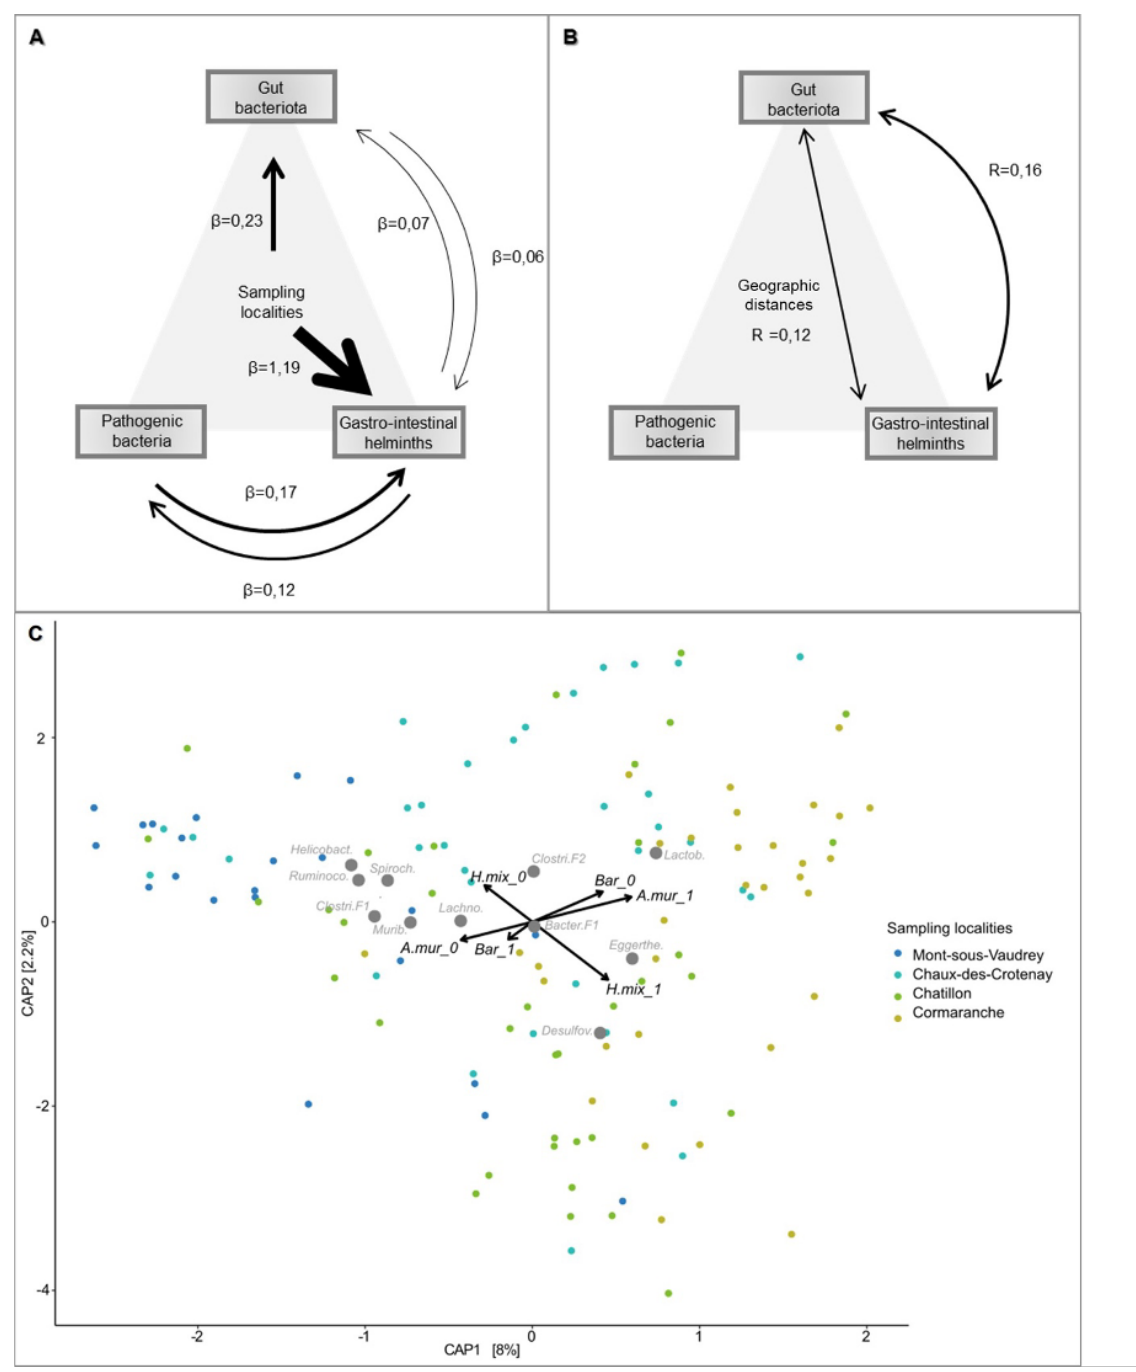
Figure 3- Associations between the diversity and composition of the three intra-host communities. The two upper diagrams show the relationships between A) the specific richness and B) the composition of the three communities, while taking into account the influence of the sampling localities or distance geographic. The effect size and the direction of the relationship between communities are represented using an arrow, its width corresponding to the estimate (β) x 10 or the correlation index R x 10. Only significant effects are represented. C) This db-RDA triplot shows the structure of the gut bacteriota and the correlations with the pathogen communities. The arrows correspond to the significant explanatory variables. Each point corresponds to an individual, and the colors correspond to the different sampling localities.